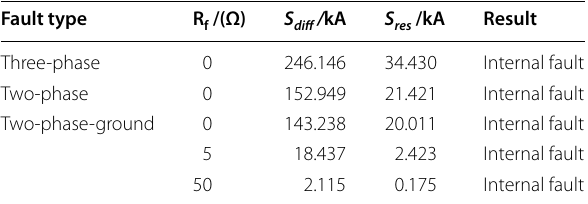
Table 5 Simulation results of N model when internal faults occur at f